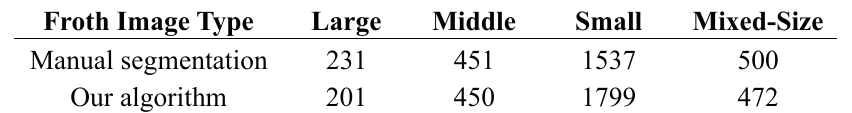
Table 2. Bubbles numbers comparison between our algorithm and manual